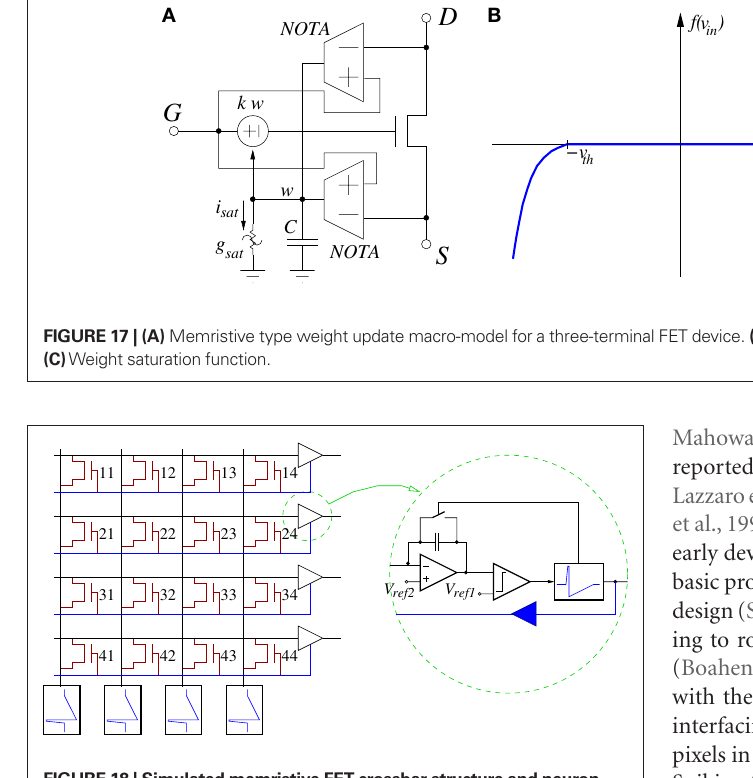
of w as w = 10 V and w = − 10 V. We can see again that some max min weights converge to the boundary values, while others stabilize at intermediate values, as is characteristic for